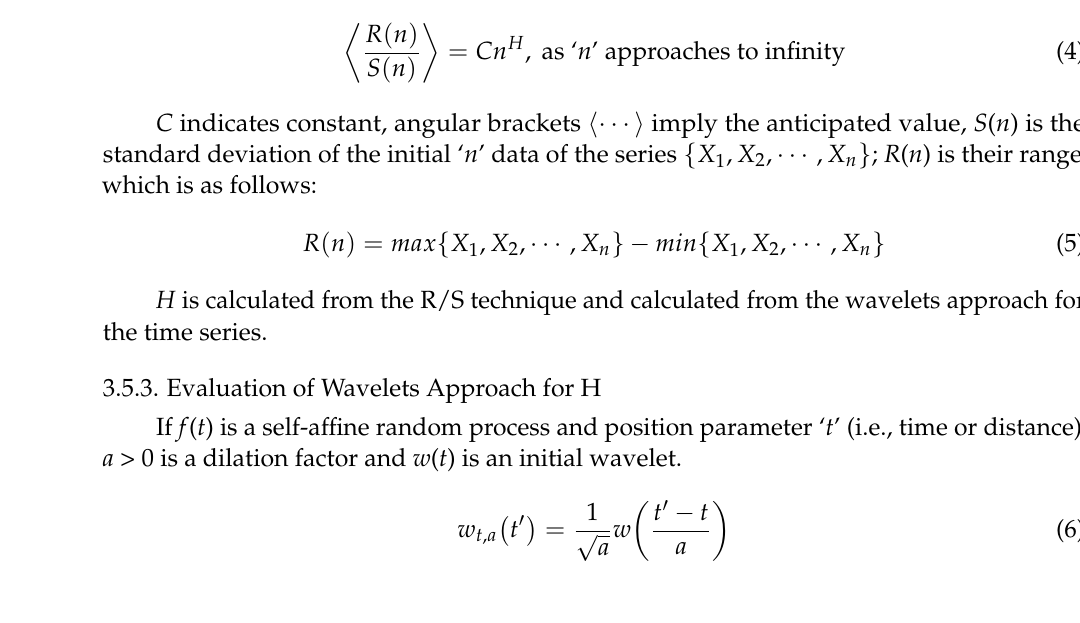
(b): Kurtosis Variation in the Water Quality Indices in 13-Experimental